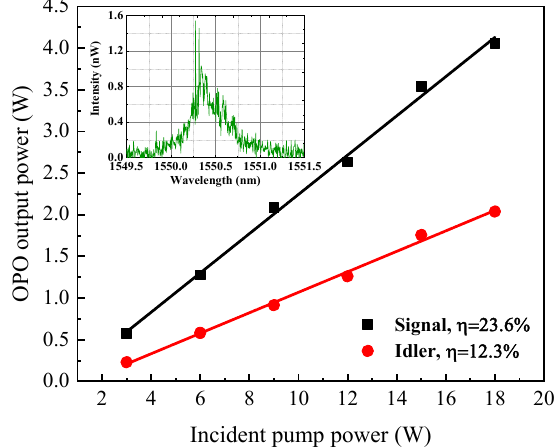
Figure 3. OPO output power versus incident pump power when the temperature is 46 °C. Inset: output spectrum of the signal without the F–P etalon.